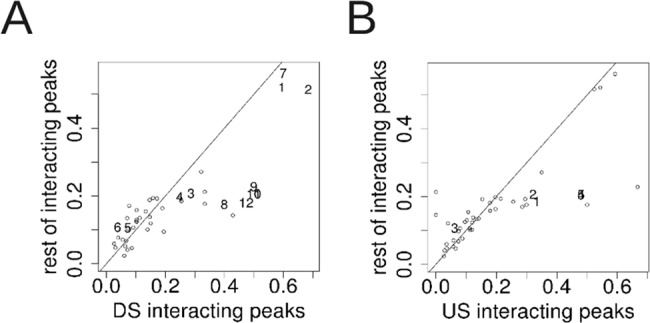
Fraction of ChIP-Seq peaks overlapping ChIA-PET interactions.Data from K562 cell line. Diagonal line is of y = x. Statistically significant data points (Fisher's Exact Test P-value < 0.05) are numbered, whereas non-significant points are shown as an empty circle. Each point represents a set of peaks. The first 5 letters of the symbol for the numbered points are listed here: (A) 1. Ctcfc 2. Ctcfl 3. Elf1s 4. MaxV0 5. Pol24 6. Pol2V 7. Rad21 8. Sp2sc 9. Thap1 10. Yy1sc 11. Yy1V0 12. Yy1V0. (B) 1. Atf3V 2. Elf1s 3. Pol2V 4. Yy1sc 5. Yy1V0. See S1 Table for the full list.